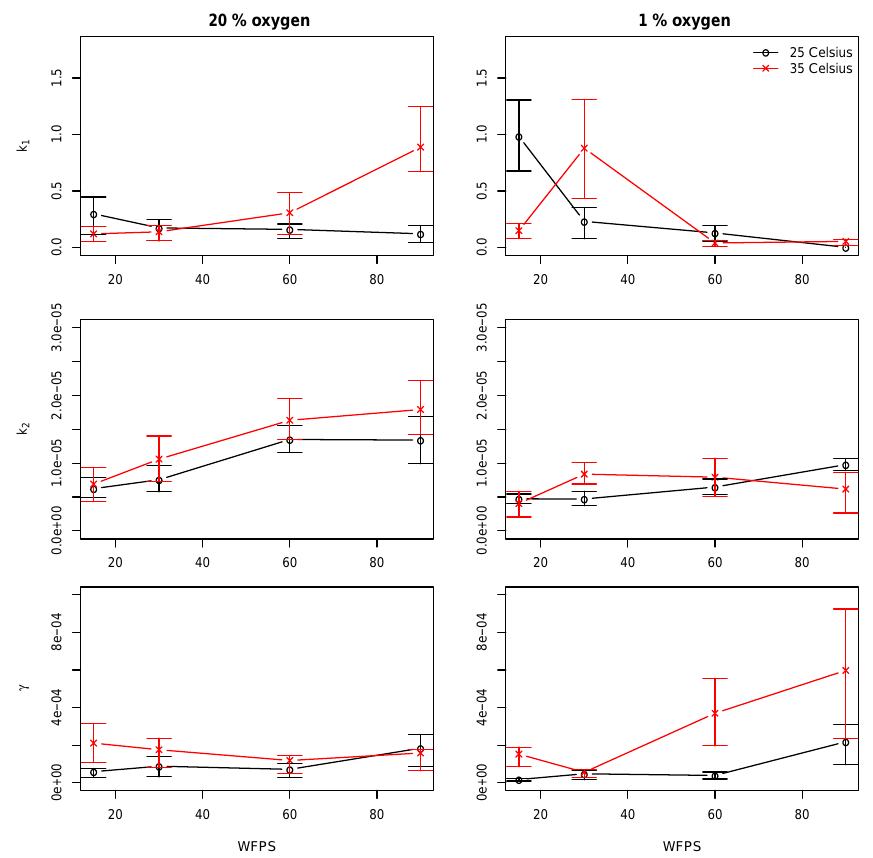
Figure 2. Results from the first model optimization procedure for the two-pool model applied to each experimental treatment independently. The parameters optimized were the following: k 1 , decomposition rate of the fast pool; k 2 , decomposition rate of the slow pool; and γ , fraction of the total initial carbon in the fast pool. The experimental treatments were water-filled pore space (WFPS; 15, 30, 60, 90%), oxygen concentration (1, 20%), and temperature (25, 35 ◦ C). The arrows represent 25 and 75% quantiles of the distribution of the parameters obtained through Bayesian